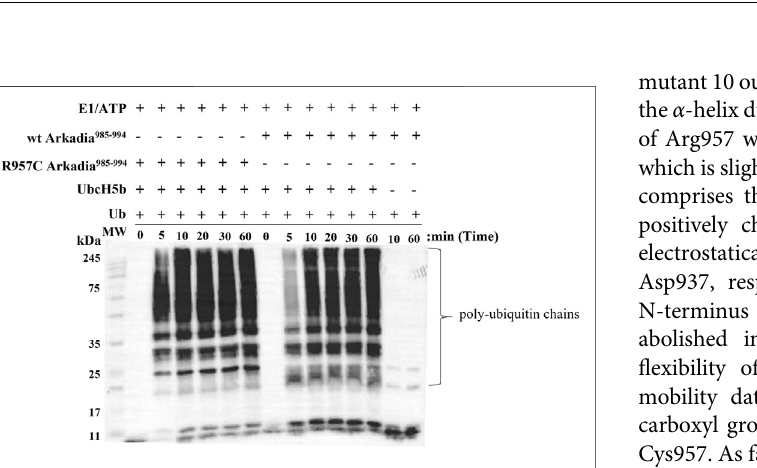
FIGURE 6 | Interaction of E3 Ub ligase Arkadia RING with the E2 UBCH5B enzyme monitored by 1 H- 15 N HSQC spectra. Diagram (A) illustrates the total CSPs measured at 1:2 M ratio for 15 N R957C Arkadia/ 14 N UBCH5B (left), while diagram (B) illustrates the CSPs for 15 N UBCH5B/ 14 N R957C Arkadia RING. Straight lines indicatetheappliedthresholdsofCSPsrepresentingtherespectiveaverageCSP(Kornhaberetal.,2006). ◆ representsprolineresiduesandresidueswithnoinformation.